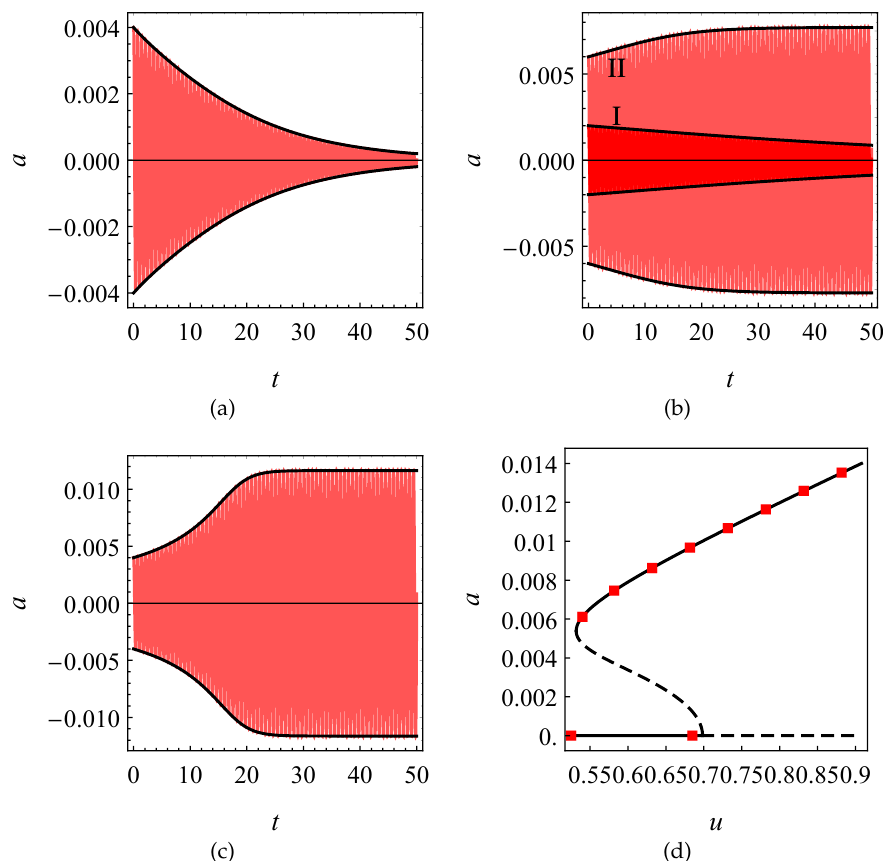
Figure 5. Comparison between exact (finite difference and numerical integration) and analytical (perturbative) results. Time-histories (filled area) vs numerical integration of the bifurcation equation (black line), when: ( a ) u < u ∗ , ( b ) u ∗ < u < u c , and ( c ) u > u c ; ( d ) bifurcation diagram, exact (red point bullets) vs analytical results (black solid